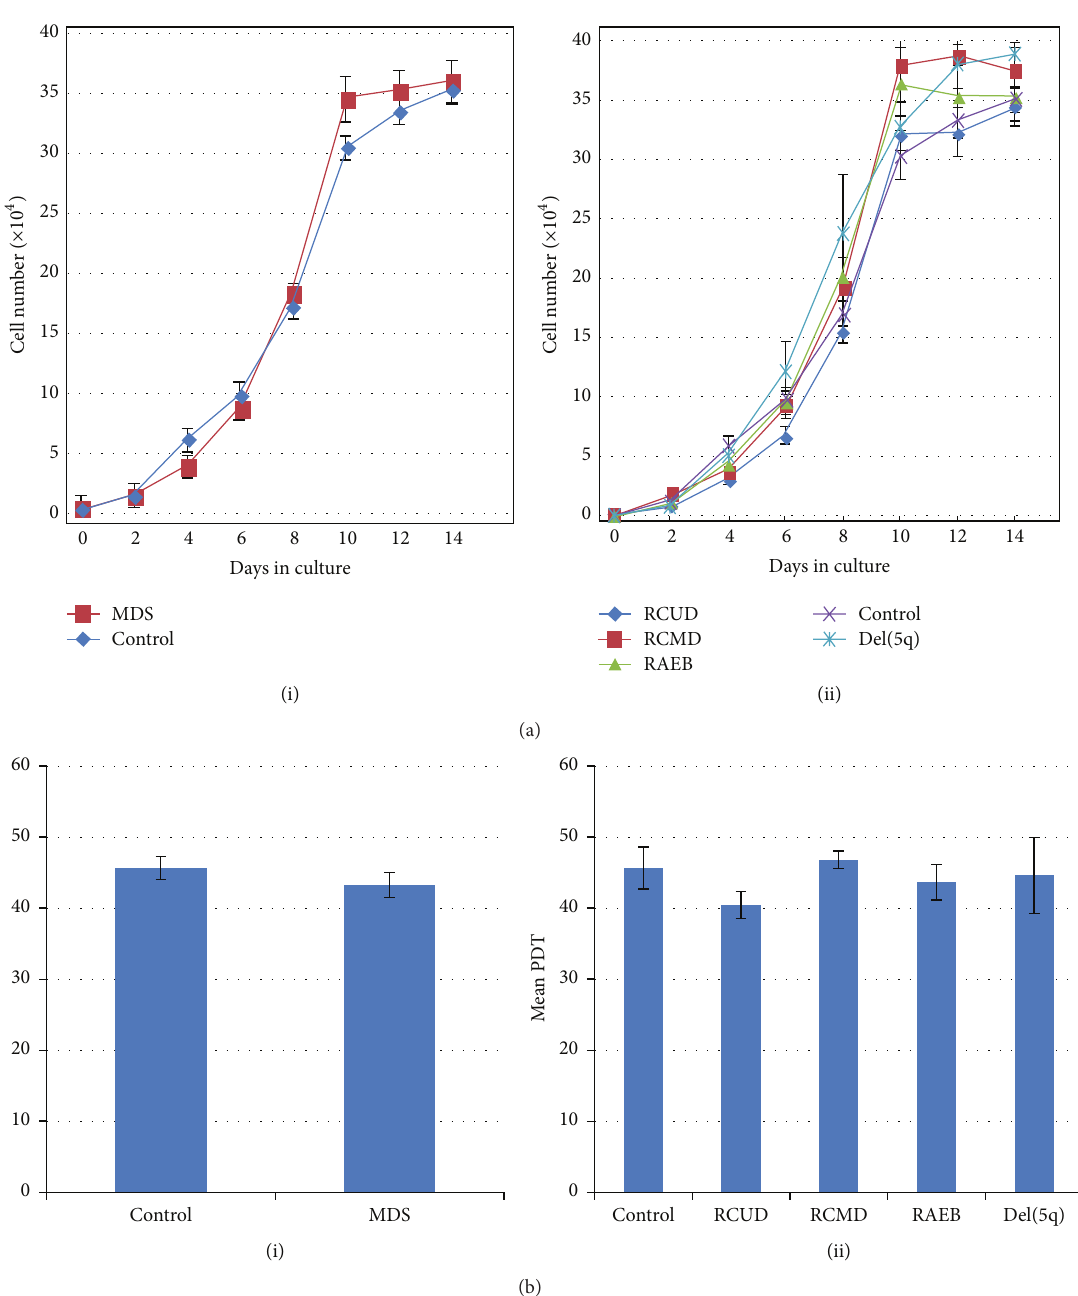
Figure 3: Proliferation pattern of MDS-MSCs. (a) Growth curves of mesenchymal stem cells isolated from MDS patients and control MSCs. (i) Comparison between control MSCs ( 𝑛 = 4 ) and MDS-MSCs ( 𝑛 = 16 ). (ii) Comparison of growth between RCUD ( 𝑛 = 7 ), RCMD ( 𝑛 = 5 ), RAEB ( 𝑛 = 3 ), del(5q) ( 𝑛 = 1 ), and control MSCs. For each sample, cells in duplicate wells were harvested every 2 days at a regular time and the average was taken. Each data point represents the mean of each group ± SEM. For del(5q) ( 𝑛 = 1 ), each data point represents the mean cell number of two independent wells ± SE. (b) Mean population doubling time (PDT). (i) Mean PDT ± SE of control and MDS-MSCs. (ii) Mean PDT ± SE of control, RCUD, RCMD, RAEB, and del(5q). Mean PDT values were not significant between control and MDS-MSCs as well as among the patient subgroups ( 𝑝 > 0.05